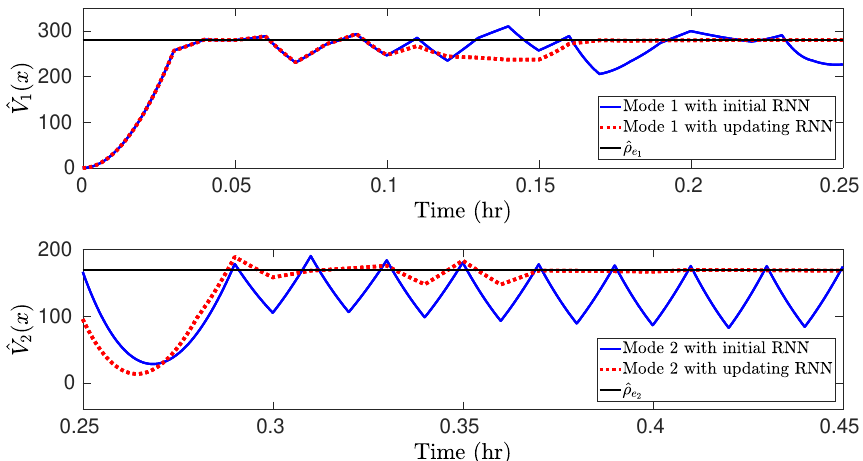
Figure 3. Comparisons of ˆ V 1 ( x ) for mode 1 and ˆ V 2 ( x ) for mode 2 under the initial offline-learning and online updating RNN